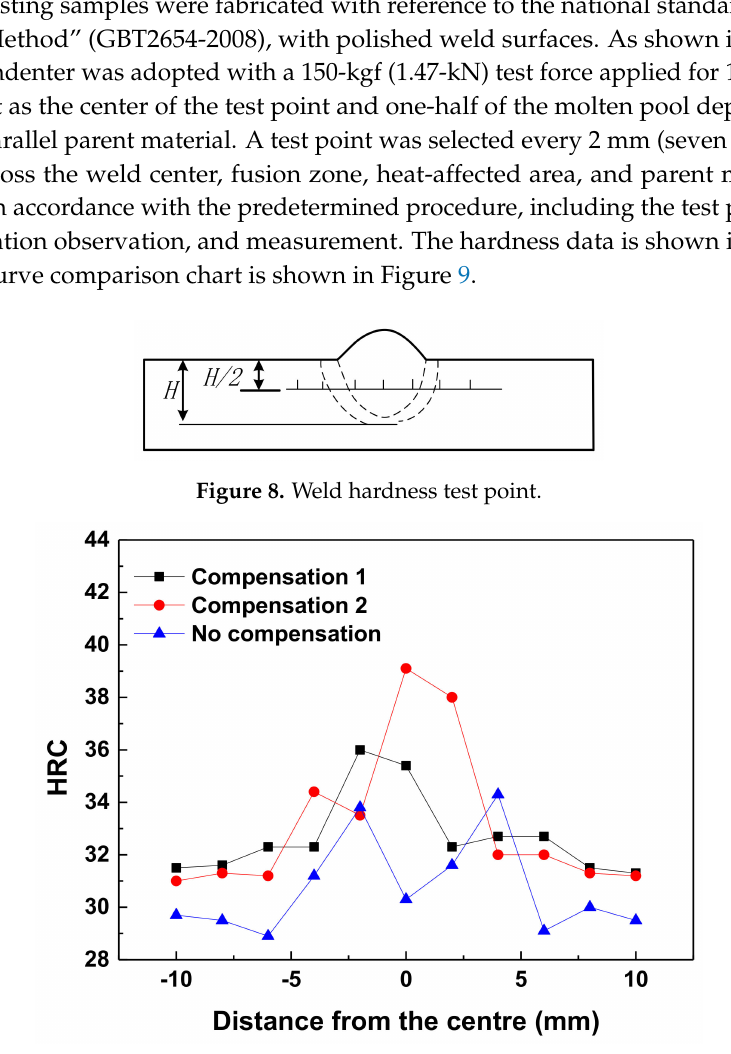
Figure 9. Comparison of hardness curves of welds formed with and without compensatory gas